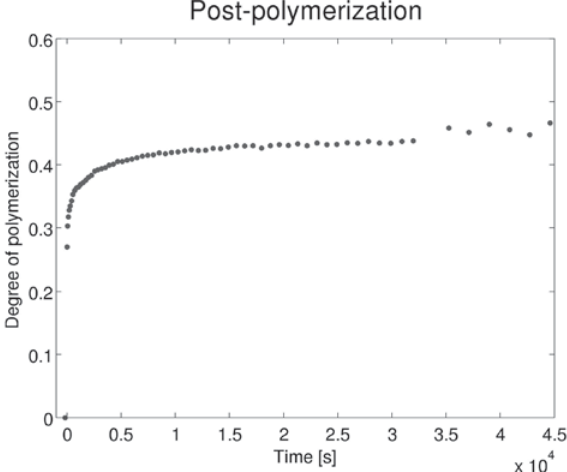
Figure 1- Conversion degree (DC) progression during the 12-hour post-curing period acquired through F-TIR analysis Figure 2- Normal probability plot of